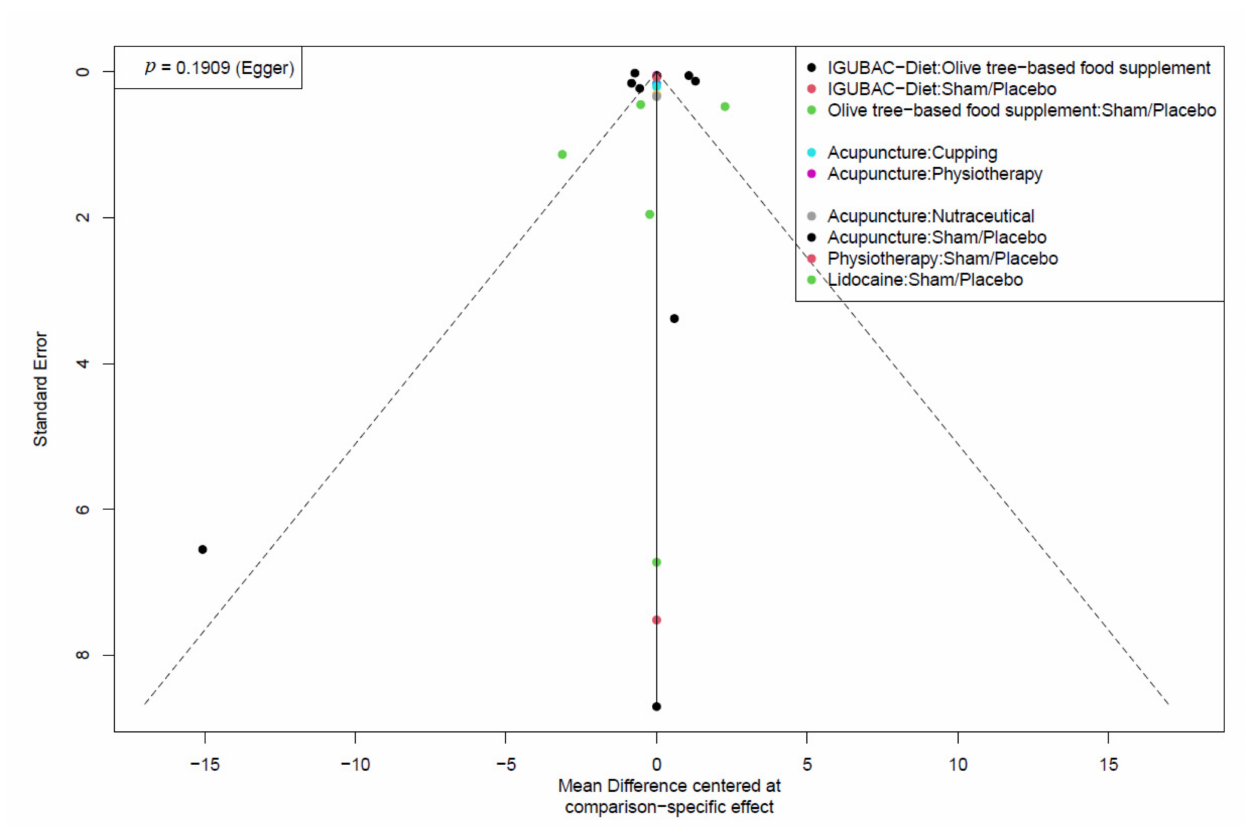
Figure 8. Funnel plot of the pain